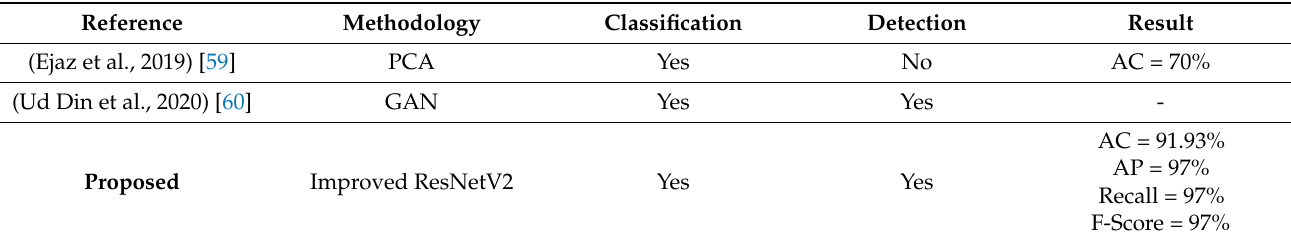
Table 4. Performance comparison of different methods in terms of accuracy (AC) and average precision